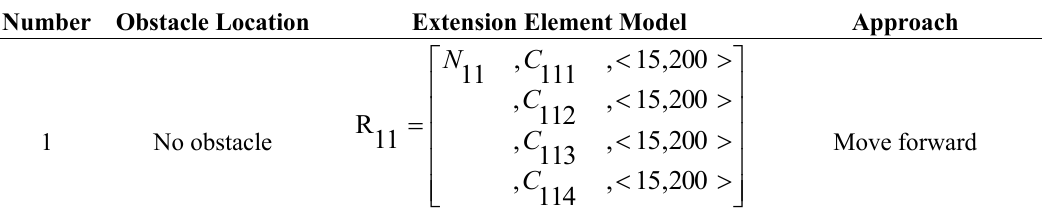
Table 2. Rule table for forward motion in the extension-element